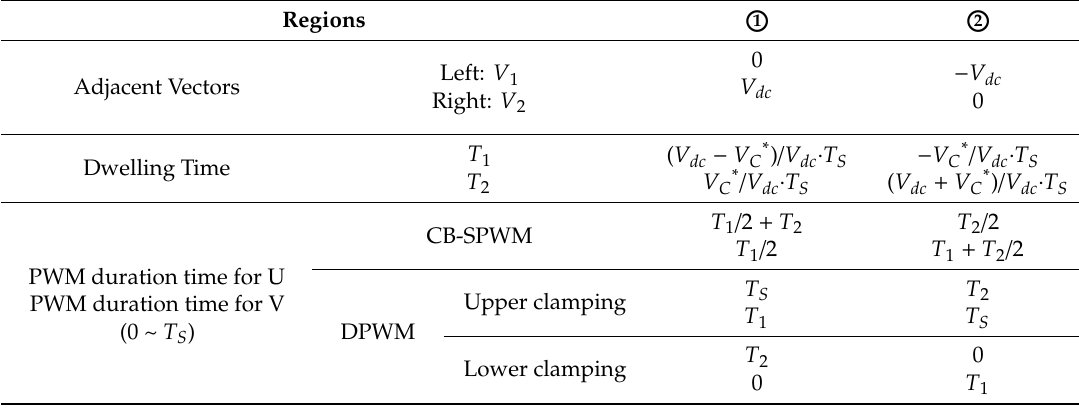
Table 1. Adjacent vectors and their dwelling times for CB-SPWM and